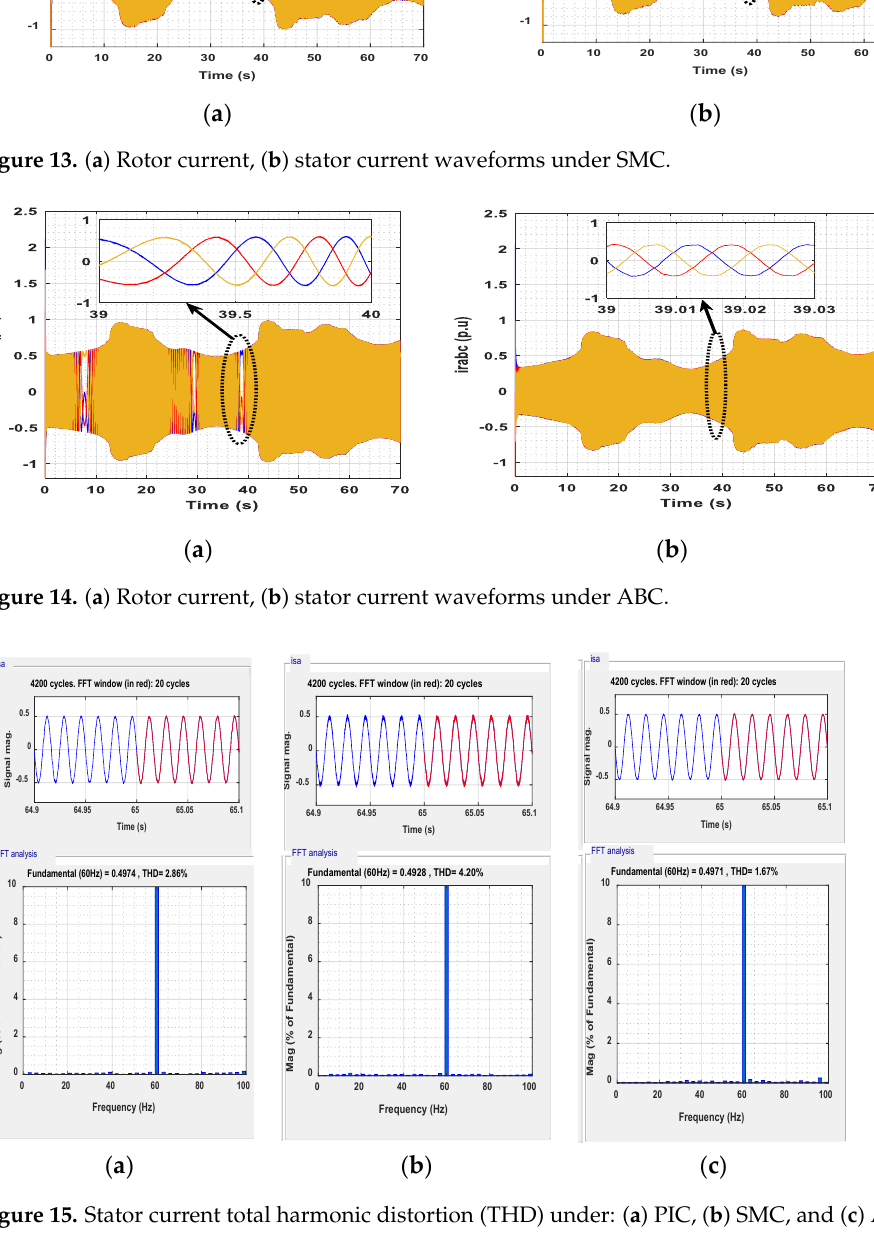
Figure 16. Bar graph showing stator current THD under: PIC, SMC, and ABC in hyposynchronous, hypersynchronous, and pitch activation modes of operation. In order to further examine and compare the robustness of the three controllers, an- other series of simulations were carried out to test the effect of step variations in the in- trinsic parameters of the DFIG. In the first evaluation, a step increase of 50% in stator and rotor resistances was introduced simultaneously at t = 10 s while the wind speed was kept constant at 8 m/s. The resulting rotor current convergence errors are plotted in Figure 17, where it can be observed that the three control schemes exhibited excellent robustness and ensure satisfactory steady-state performance even in the presence of parametric varia- tions. The second simulation was performed under the same scenarios but with the addi- tion of a 50% step increase in the rotor, stator, and mutual inductances at t = 10 s. Figure 18 shows that at the instance of parameter variation, the curves of current-tracking errors featured spikes of up to 0.12 p.u. However, ABC appeared to be the best with almost smooth curves and good tracking of set-point curves, followed by the command based on the PI regulators, which presented rapid settling time. Then, the SMC gave remarkable and superior ripples compared to those obtained by the other two commands, which were still able to attenuate oscillations under parametric variations of the machine.